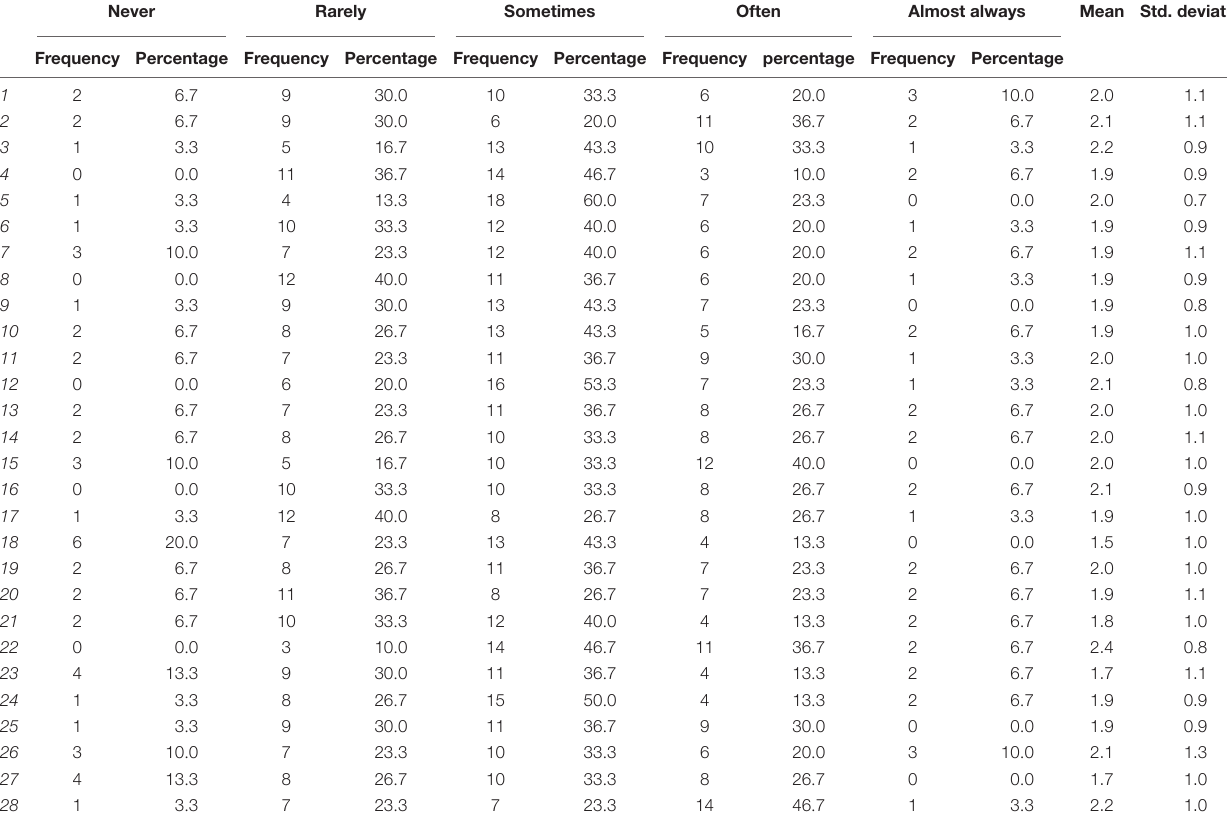
22 (“I ask the teacher a question in class.”) which was 2.3 and the lowest mean belonged to questions 26 and 28 which was 1.6. TABLE 2 | Distribution of the responses of the experimental group to the questionnaire before treatment. Never Rarely Sometimes Often Almost always Mean Std.